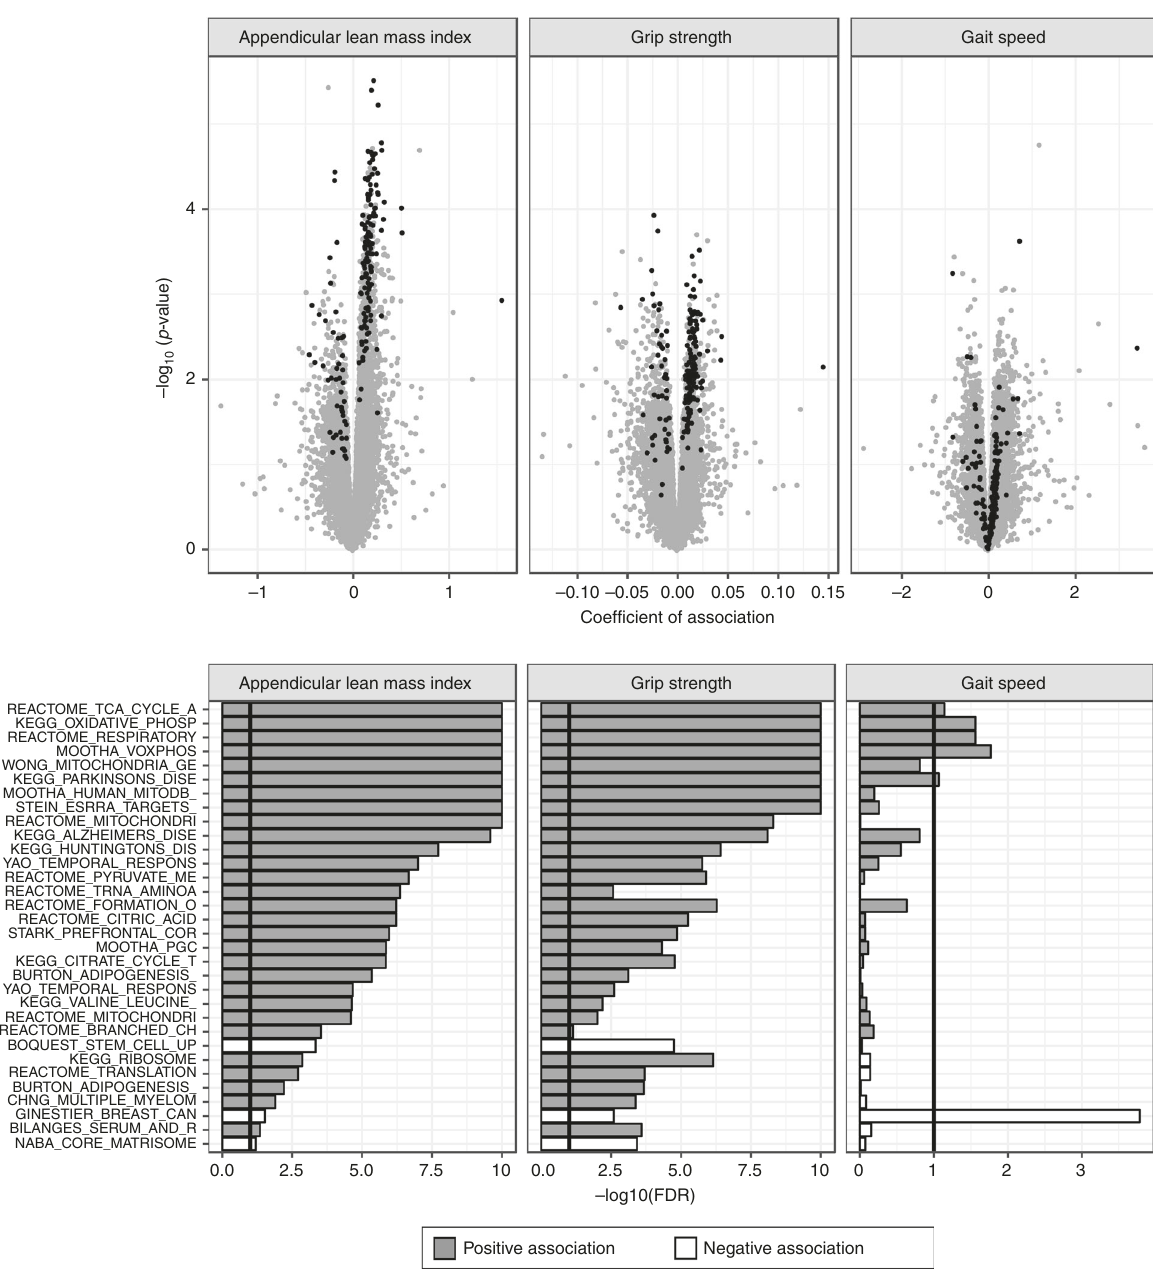
Fig. 4 The transcriptional signature of sarcopenia in human muscle is mainly driven by the loss of appendicular lean mass index (ALMi) and grip strength. a Volcano plot of genes associated with ALMi, grip strength and gait speed as continuous variables. p -values were calculated using moderated t -statistics and coef fi cients of association represent the log2 fold change of gene expression per unit of variable of interest. Genes which are differentially regulated with sarcopenia at a FDR<10% (Fig. 1a) are represented in black. b Gene-set enrichment analysis of genes associated with ALMi, grip strength, and gait speed as continuous variables using CAMERA and the C2 curated gene set collection from MSigDB. Gene sets are ordered according to the signi fi cance of their association with ALMi; only gene sets with an FDR<10% in at least one association and with a gene overlap <75% are represented. The signi fi cance threshold of 10% FDR is represented by black vertical lines and FDRs smaller than 10E − 10 are trimmed at 10E − 10. For all panels, n = 39 SSS muscle